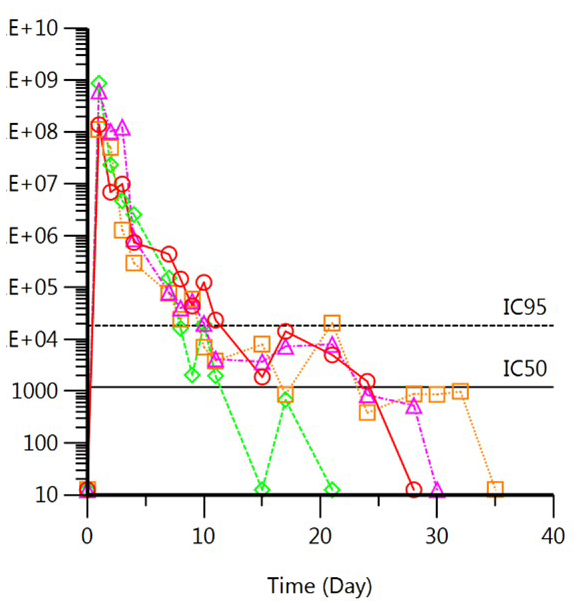
Figure 8. In vivo drug delivery profiles of MK-2048 PNP films (containing 10 mg MK-2048) in vaginal fluids. For numbers in the y-axis larger than 1000, E + n means 1 × 10 n . Films inserted on Day 0. The solid line indicates the IC 50 of MK-2048. The dash line indicates the IC 95 of MK-2048 [38] .